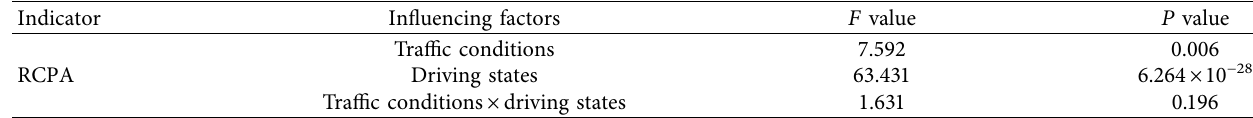
Table 11: Two-way ANOVA of RCPA.